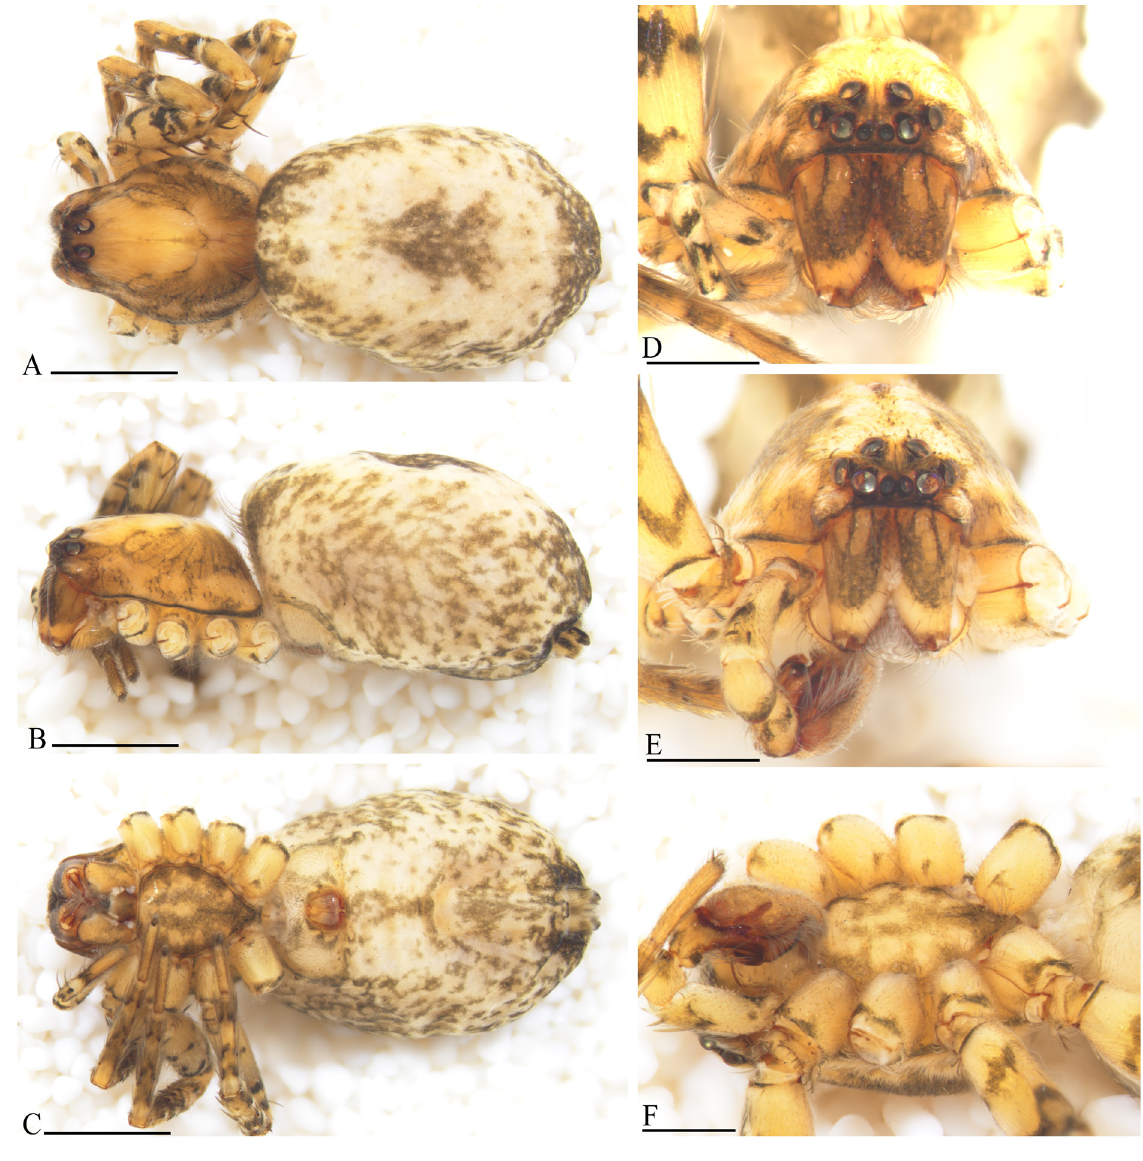
Fig. 6. Anyphaena adnani sp. nov. A–D . Paratype, ♀ (CNAN-T01546). E–F . Paratype, ♂ (CNAN-T01545). A . Dorsal habitus. B . Lateral habitus. C . Ventral habitus. D . Prosoma, anterior view. E . Prosoma, anterior view. F . Prosoma, oblique view. Scale bars: A–C = 1.0 mm; D–F = 0.5